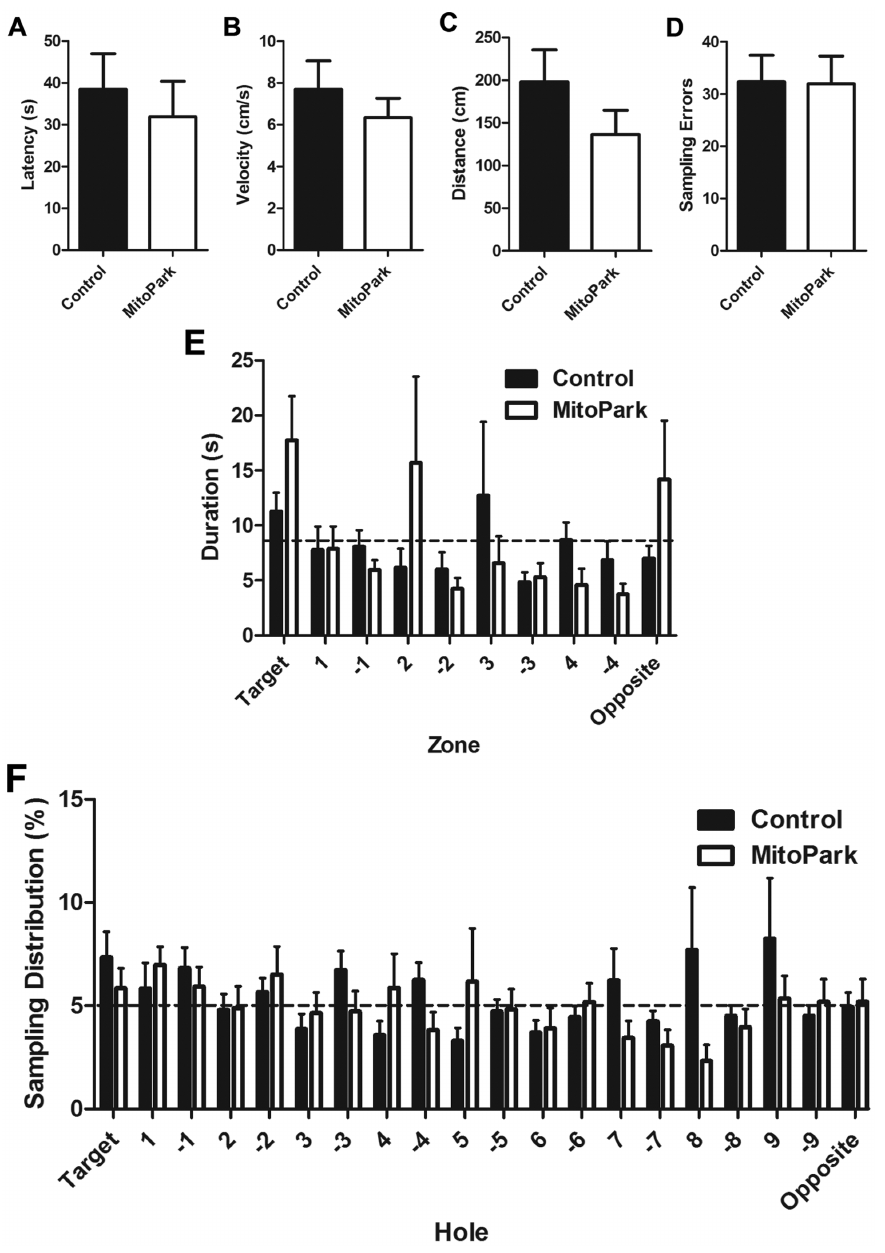
Figure 5. A second probe trial was conducted seven days after the first to assess memory of the previously learned task. The (A) latency to locate the correct target hole, (B) velocity during the trial, (C) distance traveled to locate the target hole and (D) the total number of sampling errors committed during the trial were measured in 8 week old MitoPark or wild-type phenotype littermate control mice. (E) The duration of time spent in each of ten identical virtual zones (schematic in Figure 5F) around the perimeter of the maze was recorded, and (F) the distribution of sampling errors was recorded. Dashed lines represent the theoretical threshold if exploratory behavior were random. Data represent mean 6 SEM, (n=8